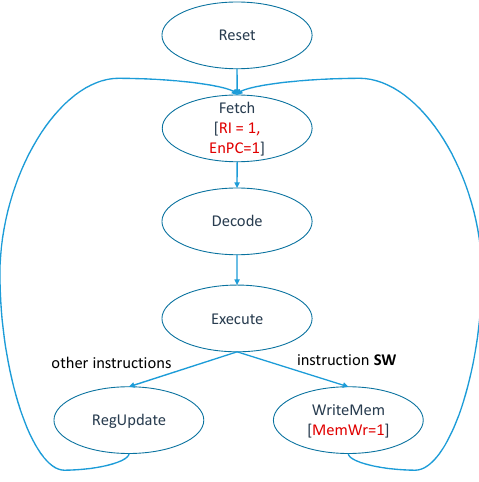
Figure 4. Incomplete state diagram of the control unit.